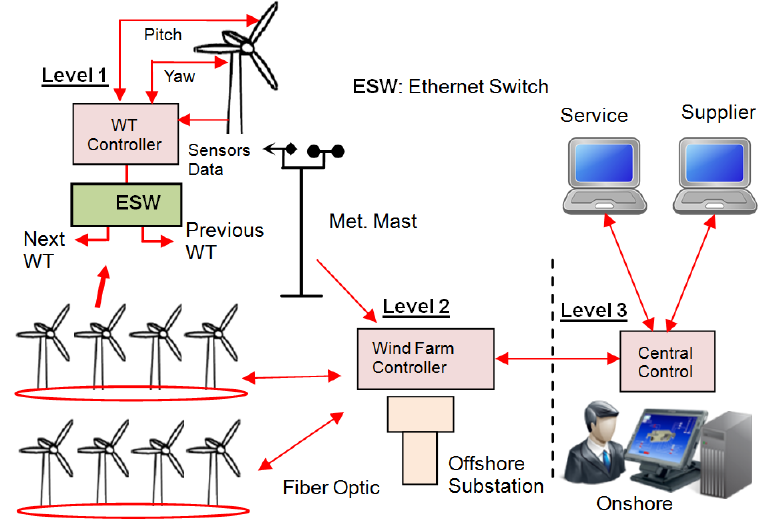
Figure 1. Schematic view of conventional wind power farms (WPF) network.